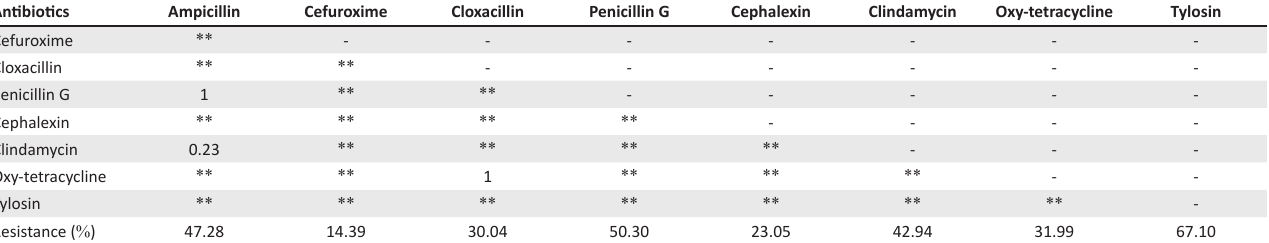
TABLE 1: P -values obtained from the pairwise comparison of proportions of prevalence between the eight antibiotics tested for antibiotic resistance of Staphylococcus aureus (over the 11 year period and in all seasons), using the Bonferroni adjustment method.